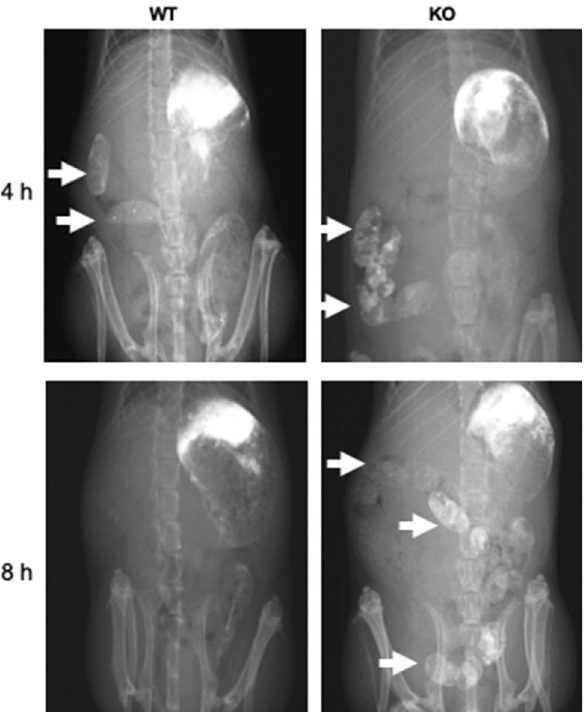
Figure 3. Intestinal transit time of the BALB/c Kif26a-KO mice. Barium sulfate was administered orally and radiographs obtained after 4 and 8 h. Barium is observed in the large intestine of the WT (n = 4, 20-week-old female), and KO (n = 4, 20-week-old female) mice at 4 h. After 8 h, barium sulfate remains in the large intestine (arrows) of the KO mice but has been excreted from the large intestine in the WT mice. Areas in the upper left part of each radiograph are associated with barium sulfate that remained attached to the stomach